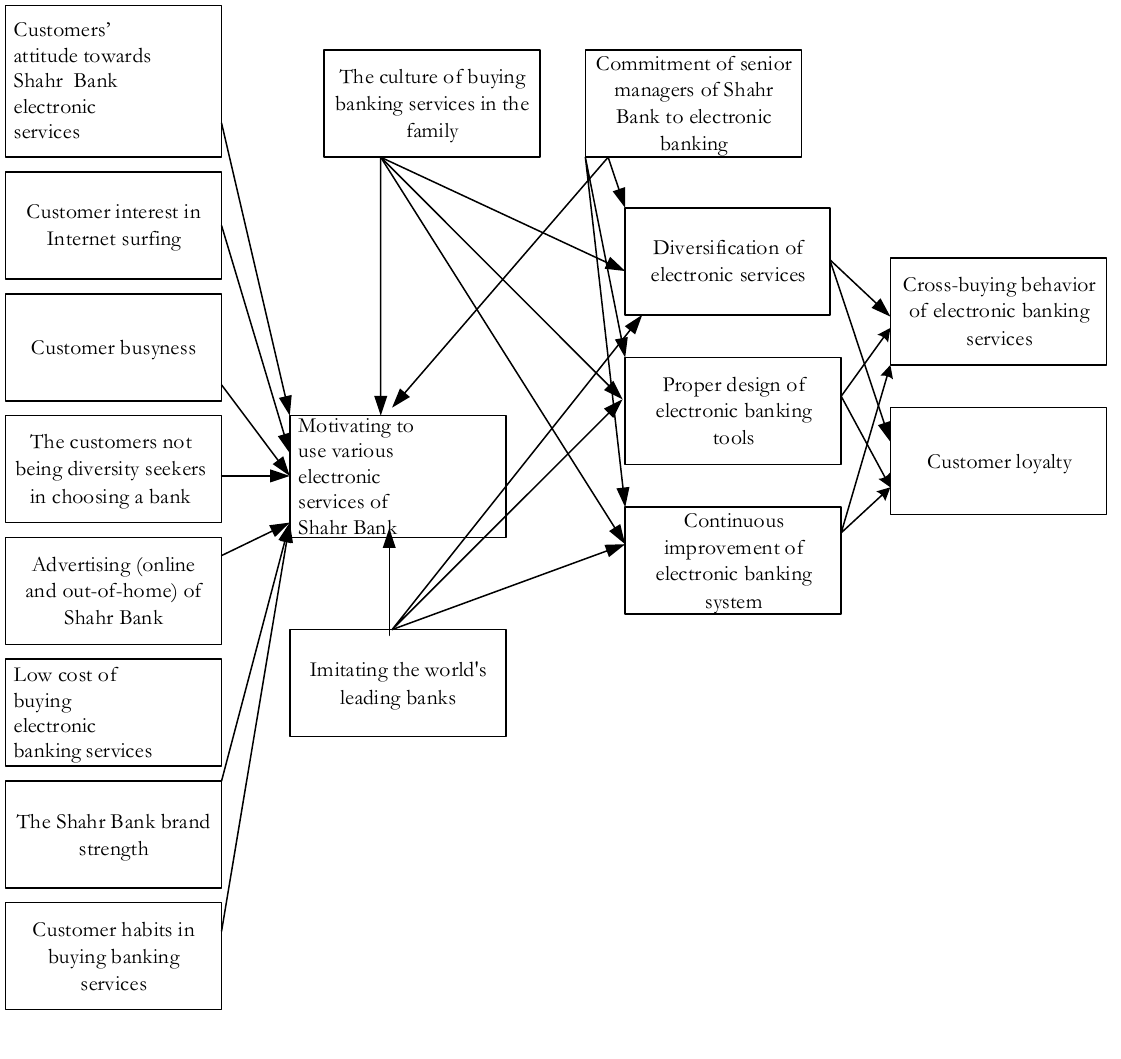
Fig . 3 . Conceptual model of